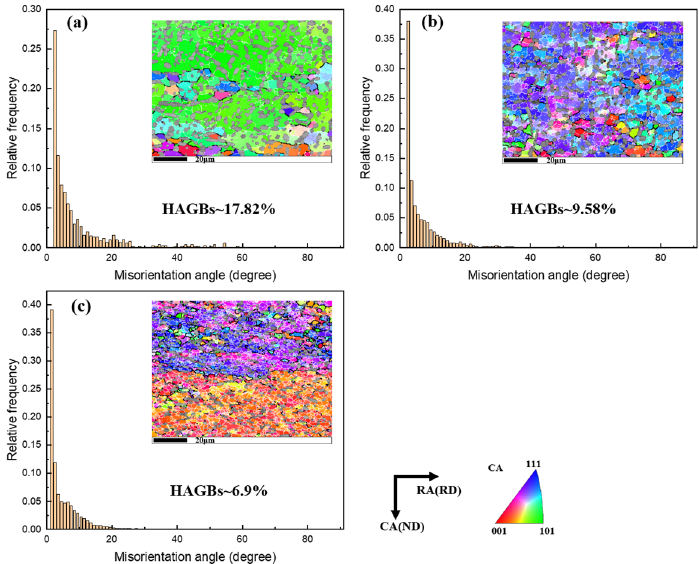
Figure 9. Distribution of the grain boundary misorientation in the β phase for the deformed microstruc- ture and the corresponding IPF maps at different deformation conditions: ( a ) 740 ◦ C/0.0001 s − 1 ; ( b ) 740 ◦ C/0.01 s − 1 ; ( c ) 740 ◦ C/1 s − 1